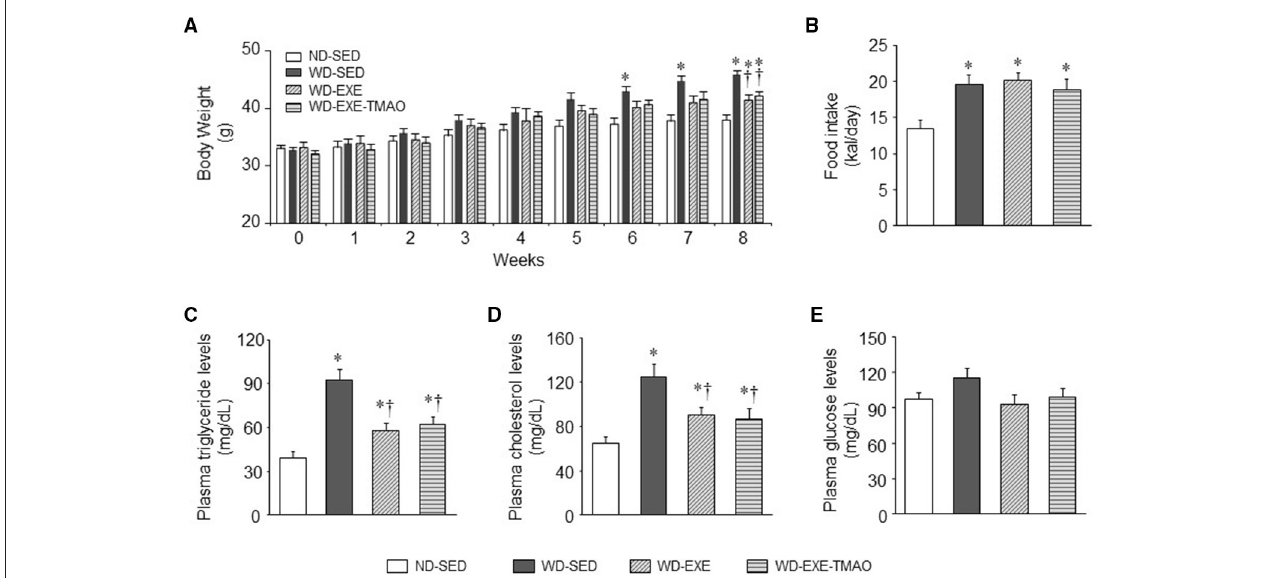
FIGURE 1 | Effects of voluntary exercise and TMAO supplementation on body weight, food intake, and metabolic disorders in mice fed a western diet (WD). Compared with normal diet (ND)-sedentary mice, WD-sedentary mice gained significantly more body weight (A) had increased daily caloric intake (B) and developed dyslipidemia (C,D) after 8 weeks of feeding. Voluntary exercise did not alter daily caloric intake, but partially attenuated weight gain and dyslipidemia. TMAO administration had no effects on these measured parameters in mice fed a WD. There were no differences in plasma glucose levels among the four groups (E) . Sedentary: SED; voluntary exercise: EXE. Data are presented as mean ± SE ( n = 10 for each group). * P < 0.05 vs. ND-SED; † P < 0.05 vs. WD-SED.